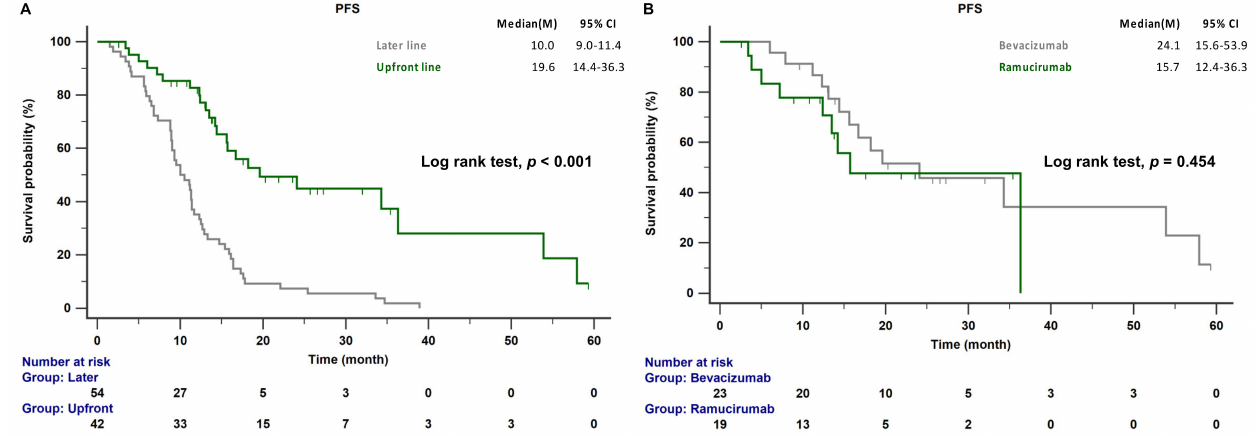
Figure 2. ( A ) PFS of patients with EGFR-mutant NSCLC receiving front-line and later-line therapy. ( B ) PFS of patients with EGFR-mutant NSCLC treated with front-line bevacizumab or ramucirumab combination therapy. EGFR, epidermal growth factor receptor; PFS, progression-free survival.